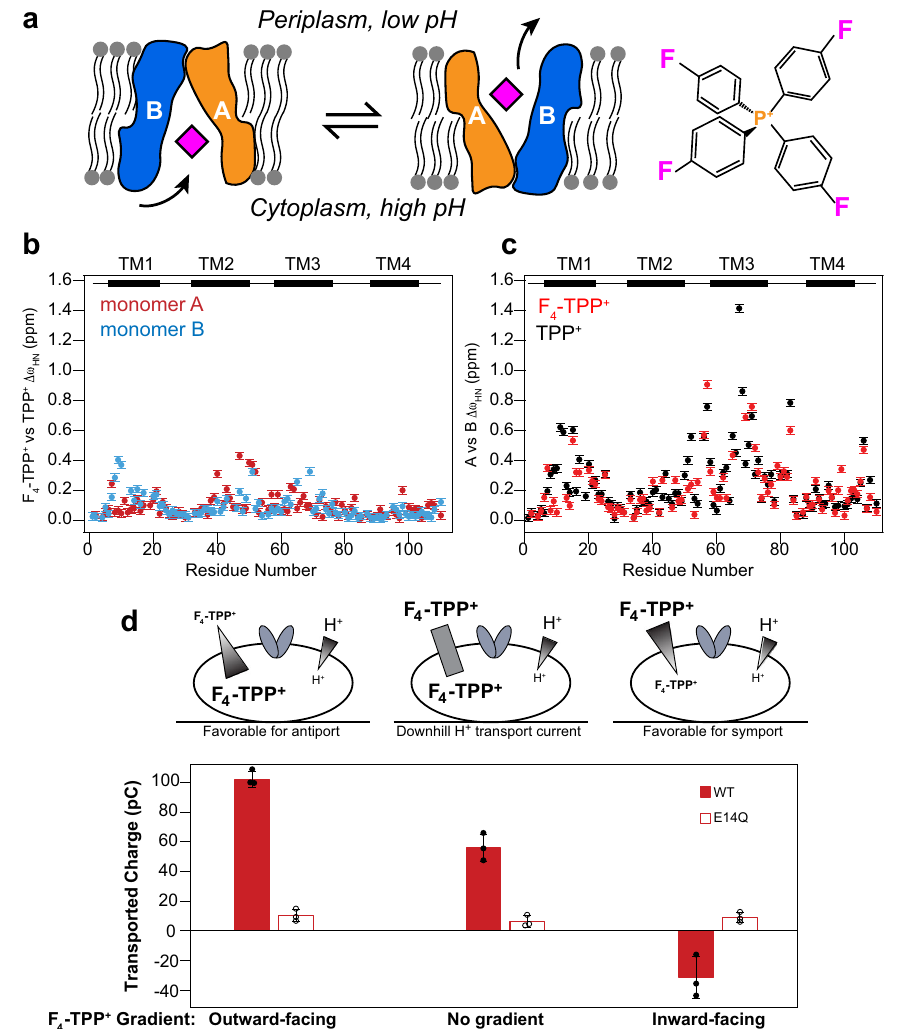
Fig. 1 EmrE binds and transports F 4 -TPP + in a similar fashion to TPP + . a Schematic model of the alternating-access mechanism of the asymmetric EmrE homodimer to export polyaromatic substrates out of bacterial cells. The F 4 -TPP + structure is shown on the right. b Amide H N and 15 N chemical shift difference between F 4 -TPP + and TPP + bound S64V-EmrE in lipid bicelles. Red: subunit A; Blue, subunit B. Small chemical shift differences are observed, indicating that TPP + fl uorination has little effect on the protein structure. Error bars are ±0.025 ppm based on spectral resolution. c Amide H N and 15 N chemical shift difference between subunits A and B of bicelle-bound S64V-EmrE. Red: F 4 -TPP + bound protein data; Black: TPP + -bound protein data. The structural asymmetry between the two subunits is similar for the two substrates. Error bars are ±0.025 ppm based on spectral resolution. d Solid- supported membrane electrophysiology data of F 4 -TPP + transport by wild-type EmrE, driven by an inward pH gradient. When the F 4 -TPP + gradient is in the opposite direction from the pH gradient, net current increases compared with when the drug gradient is absent. When the substrate gradient is in the same direction as the pH gradient, net current decreases. Thus, F 4 -TPP + is a canonical antiported substrate of EmrE. The E14Q mutant data serve as controls. Raw current traces and additional details are shown in Supplementary Figure 3. Error bars represent the standard error of three replicates using independently prepared sensors and the three individual data points are shown as